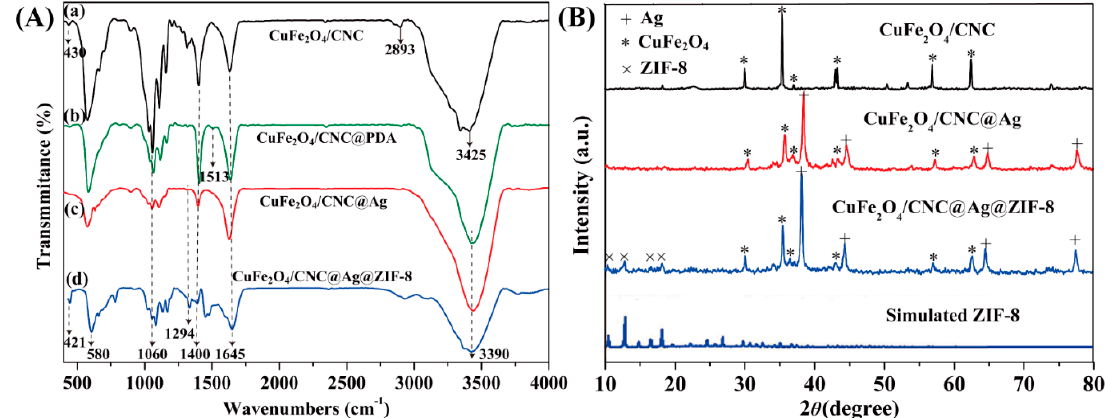
Figure 3. ( A ) Fourier transform infrared (FTIR) spectra of ( a ) CuFe 2 O 4 /CNC, ( b ) CuFe 2 O 4 /CNC@PDA, ( c ) CuFe 2 O 4 /CNC@Ag, and ( d ) CuFe 2 O 4 /CNC@Ag@ZIF-8 nanocomposites; ( B ) XRD diffraction